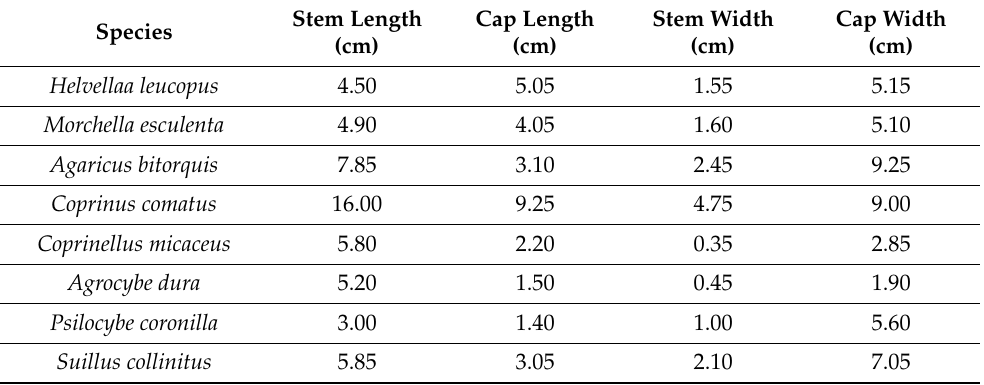
Table 2. Determination of length and width sizes in some naturally grown mushroom